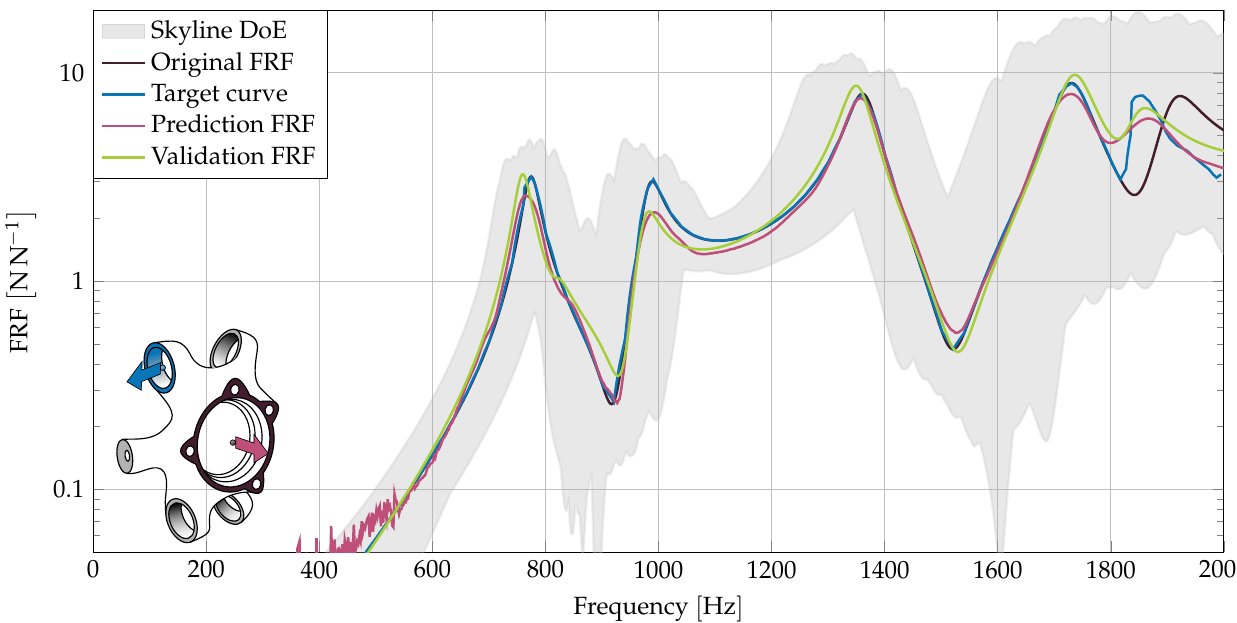
Figure 8. Optimization using a matching-curve to achieve an eigenfrequency reduction at